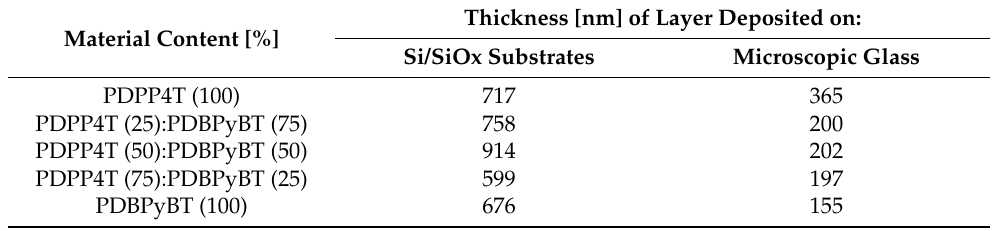
Table 2. Thickness of layers deposited on silicone and glass substrates.